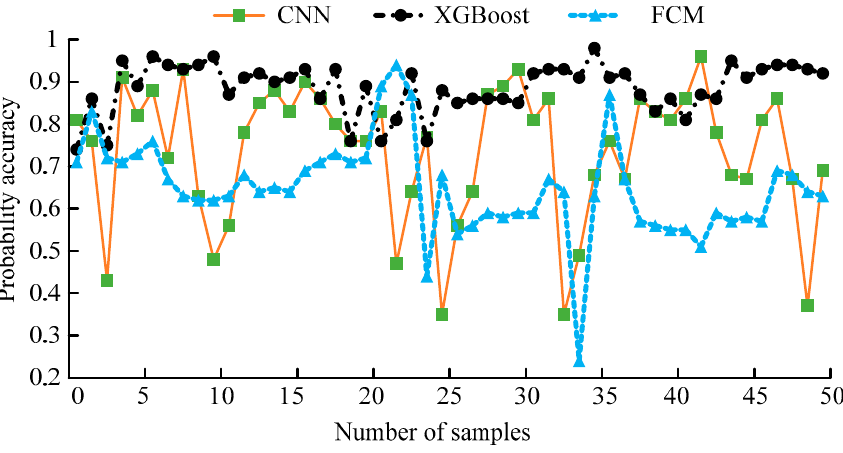
Figure 6. Testing of Different Intrusion Detection Methods in the